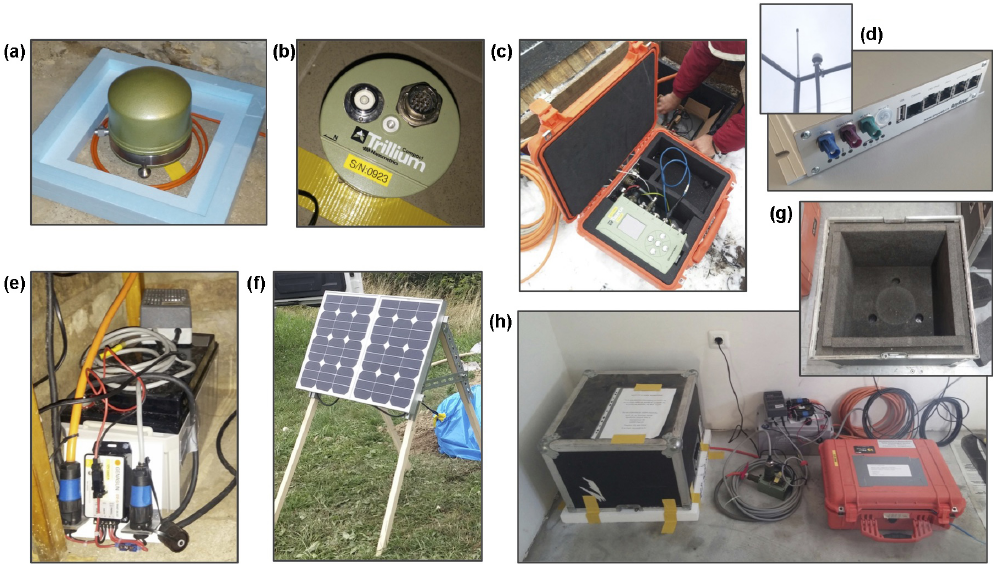
Figure 2. Components of an ETH temporary station. (a) STS-2 sensor, (b) Trillium Compact 120s sensor, (c) Taurus digitizer, (d) Router (AnyRover), GPS and GPRS antenna, (e) battery, (f) solar panel, (g) thermal isolation, (h) typical final in-house station configuration with all the